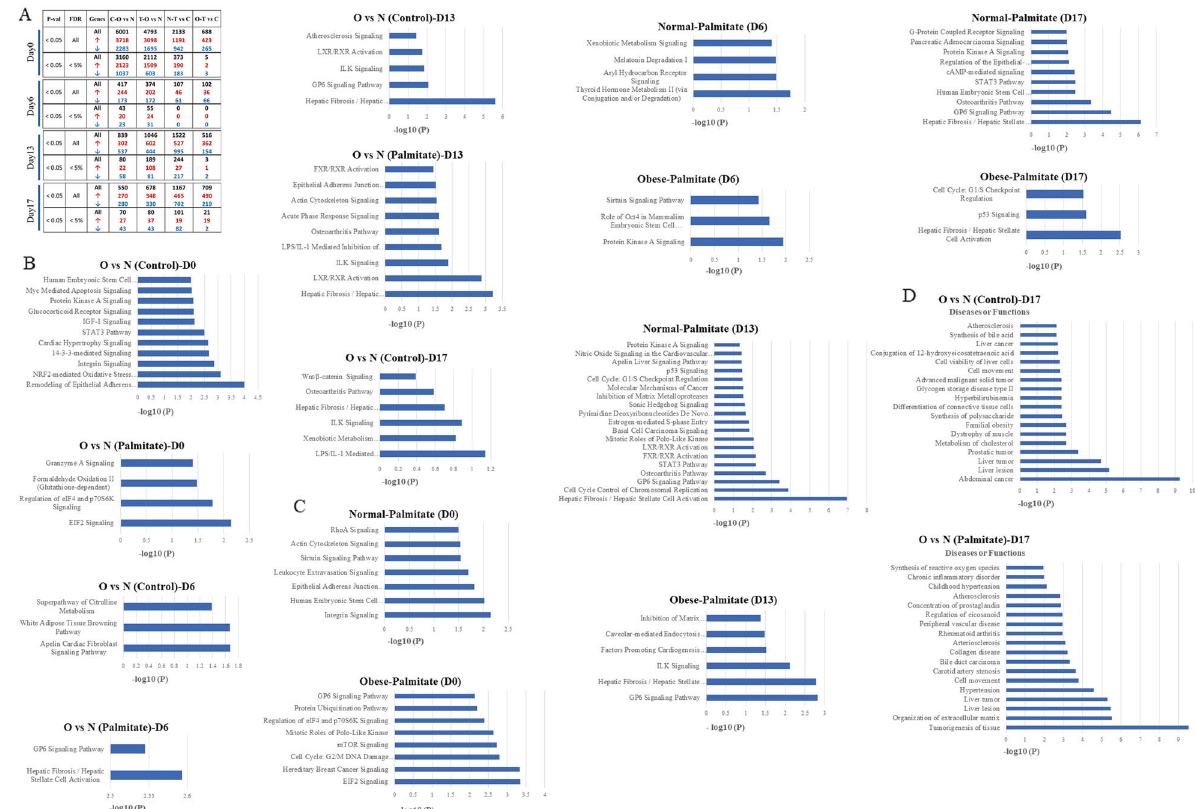
Fig. 3 Pathway analysis and disease association of DEGs in control (C) and palmitate treated (T), normal (N)-iPSCs, and obese (O)-iPSCs during in vitro hepatocyte differentiation. A The number of genes up/downregulated in four comparison groups (O vs N in C and T iPSCs and T vs C in N-iPSCs and O-iPSCs with different p values and false discovery rate (FDR). B , C Ingenuity Pathway Analysis was performed on the list of genes signi fi cantly affected ( p value ≤ 0.5) in comparison groups B O vs N in C and T-iPSCs and C T vs C in N and O-iPSCs on D0, D6, D13 and D17 of hepatic differentiation. D Disease/Function association analysis on the list of genes affected signi fi cantly ( p value ≤ 0.5) in C and T, normal (N) and obese (O)-iPSCs on D17 of hepatocyte